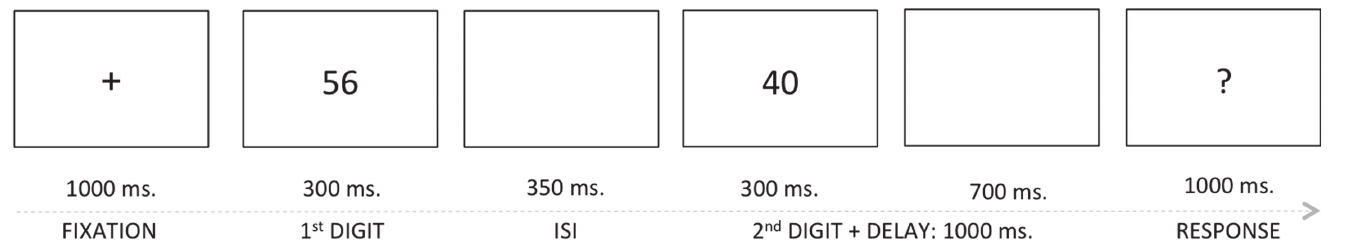
Fig 1. Example of one trial. Each trial consisted of a fixation point that appeared for 1000 ms, a first number that lasted 300 ms. followed by a blank screen for 350 ms. and finally a second number that appeared for 300 ms. After 700 ms a delayed response was